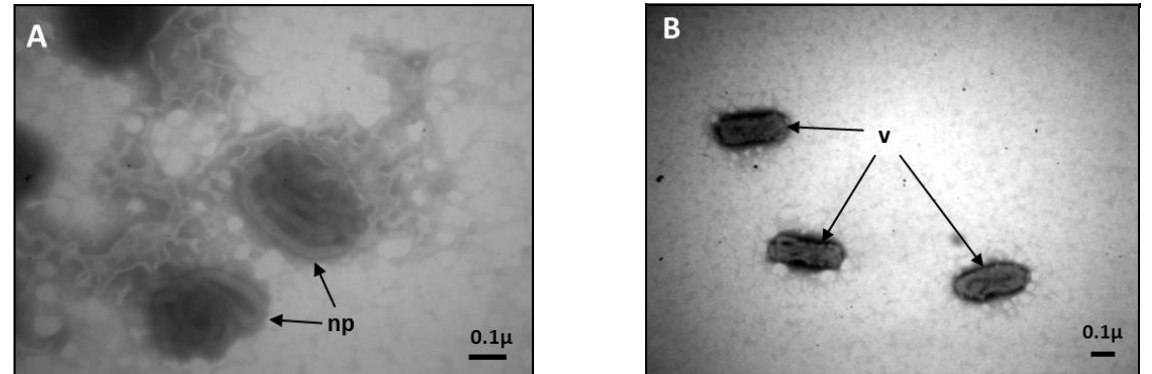
Figure 1. Morphology of AmFV virions: ( A , B ) Electron micrographs of “milky” bee hemolymph containing characteristic AmFV nucleoproteins (np) and enveloped virions (v). Approximate size is indicated by scale bars.